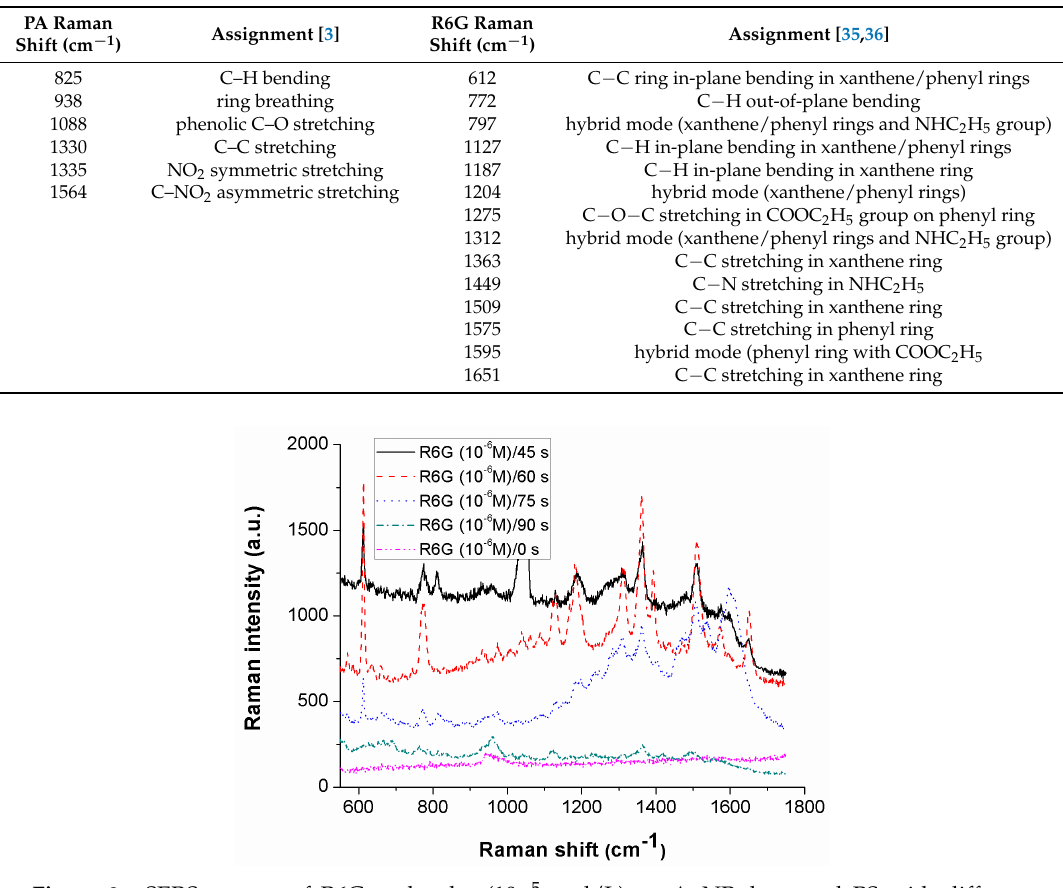
Table 1. Assignment of vibrational modes in SERS Spectra of Rhodamine 6G dye (R6G) and picric acid (PA).